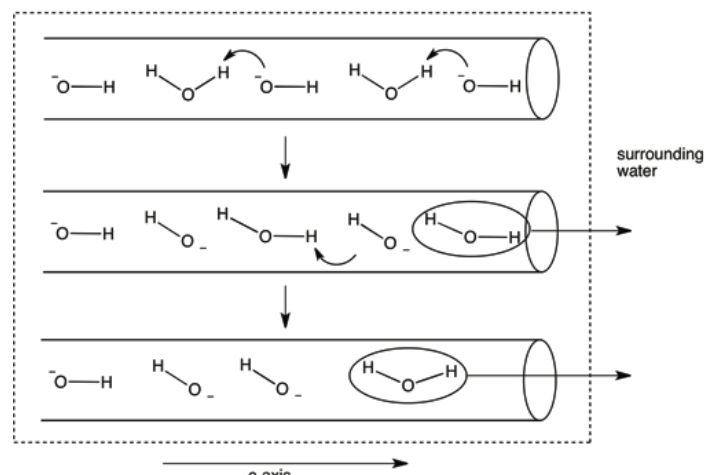
Figure 14. Model invoking proton transfers from water molecules to hydroxide ions in the c-axis channels. This model eliminates the necessity for translation of water molecules past hydroxide ions as the former exit the c-axis